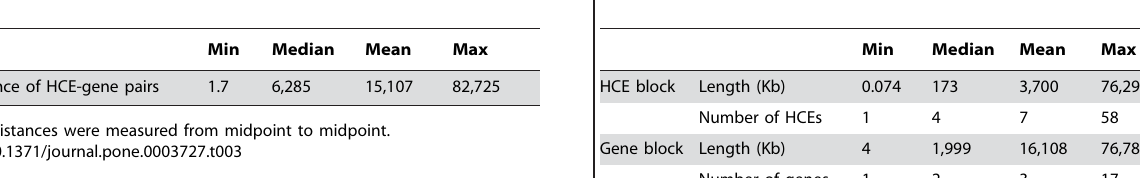
Table 3. The distances of HCE-gene pairs in the human genome (Kb).